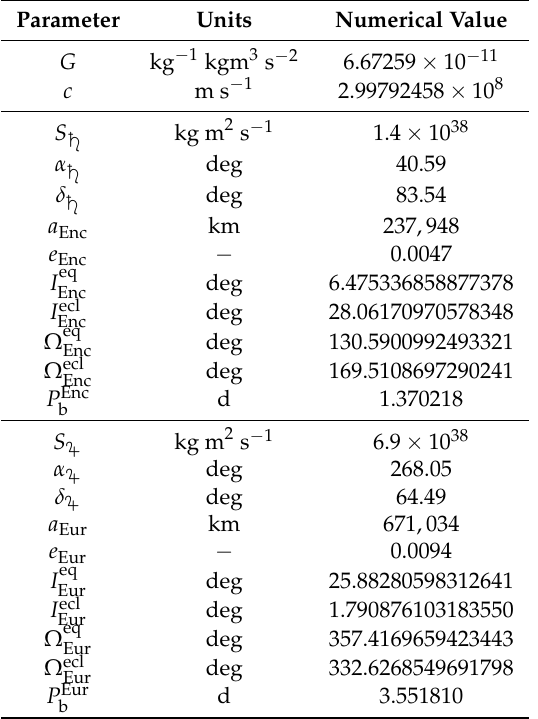
Table A1. Relevant physical and orbital parameters for Saturn, Jupiter, Enceladus and Europa. Most of the reported values come from Petit, Luzum & et al. [29], Seidelmann et al. [30], Soffel et al. [31] and references therein. The source for the orbital elements referred to either the mean ecliptic (ecl) at the reference epoch J2000.0 or the mean Earth’s equator (eq) at the same epoch is the freely consultable database JPL HORIZONS on the Internet at https://ssd.jpl.nasa.gov/?horizons from which they were retrieved by choosing the time of writing this paper as input